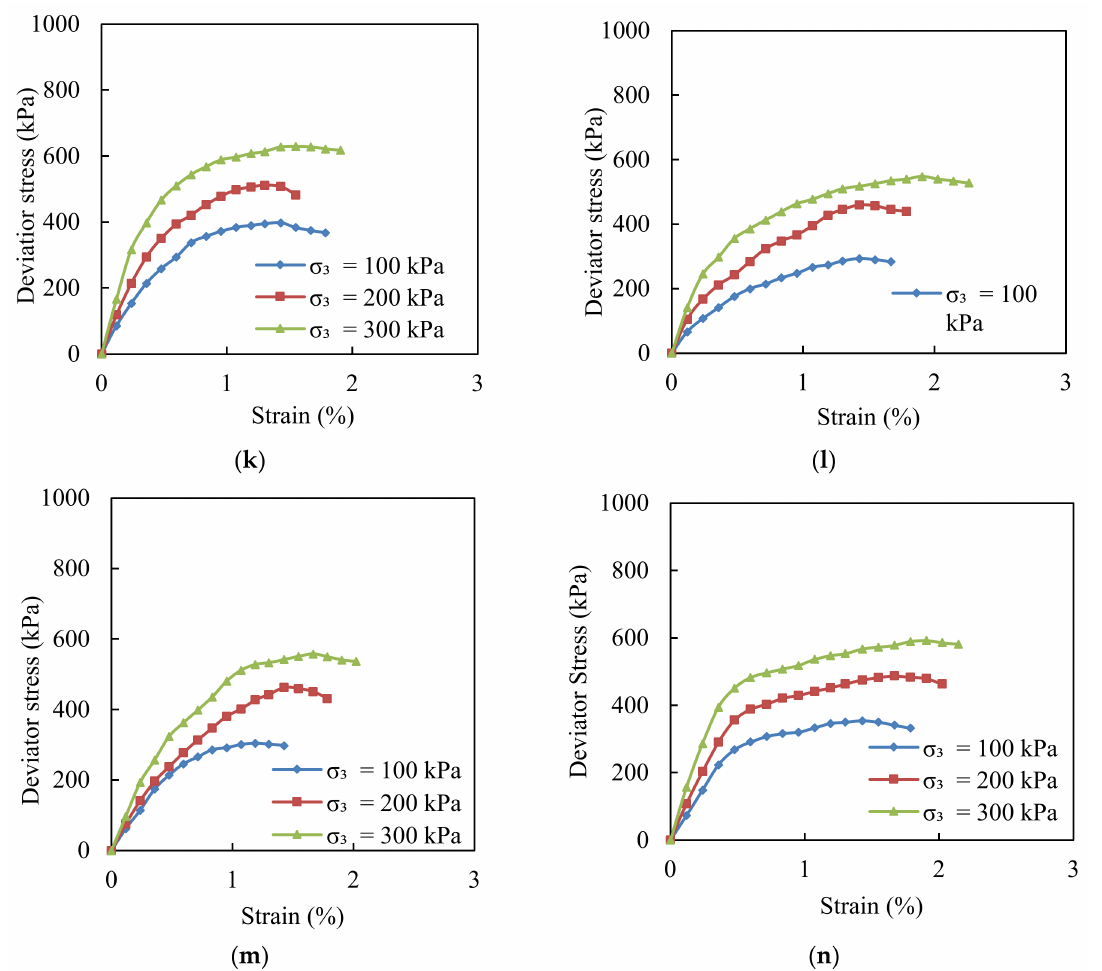
Figure 9. Deviator stress versus axial strain curves of fly ash, bentonite, and fly ash–bentonite in different ratios with layers. ( a ) Fly ash. ( b ) Bentonite. ( c ) F:B = 1:1, N = 1, F = 2L, B = 1L. ( d ) F:B =